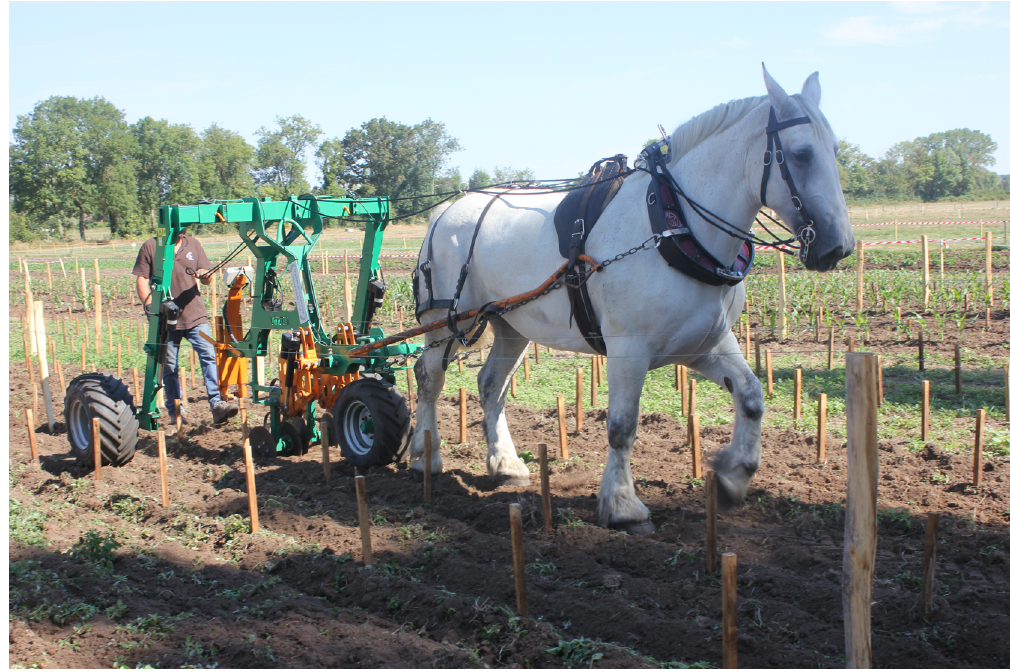
Figure 3: Demonstration of new agricultural implements specially designed for vineyards on a trellis, presented during the Trait Comt’Est 2016 (France), one of the most important European events of the sector in 2016